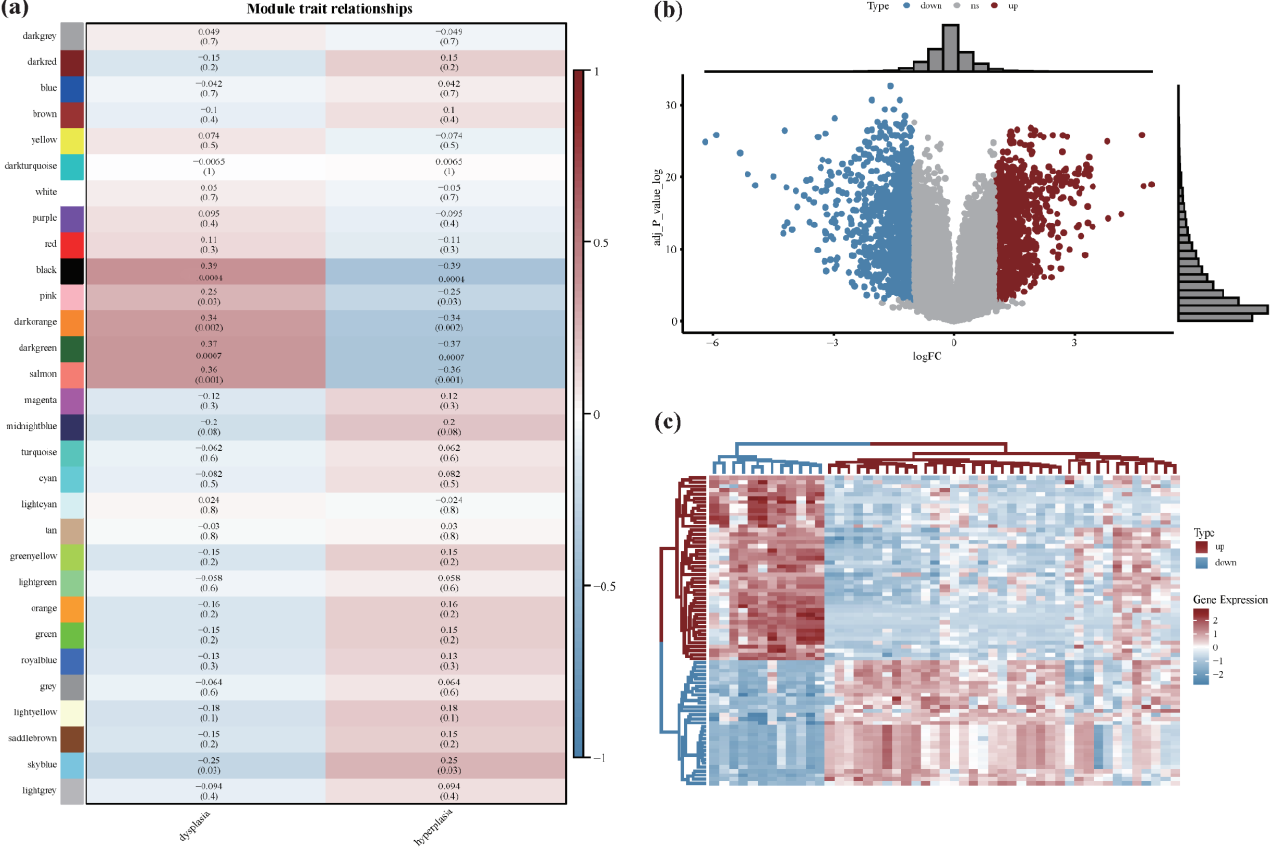
Figure 2. Differential expression analysis between OL and OSCC: ( a ) 30 co-expression modules were constructed and displayed in different colors; ( b ) the abscissa is log2 fold change (logFC), the ordinate is log (adj p -value), red nodes are up-regulated differentially expressed genes (DEGs), while blue nodes are down-regulated DEGs, and gray nodes are not significantly DEGs. ( c ) The expression trend of DEGs was represented using a heat map. Red color indicates up-regulation, and blue indicates down-regulation.